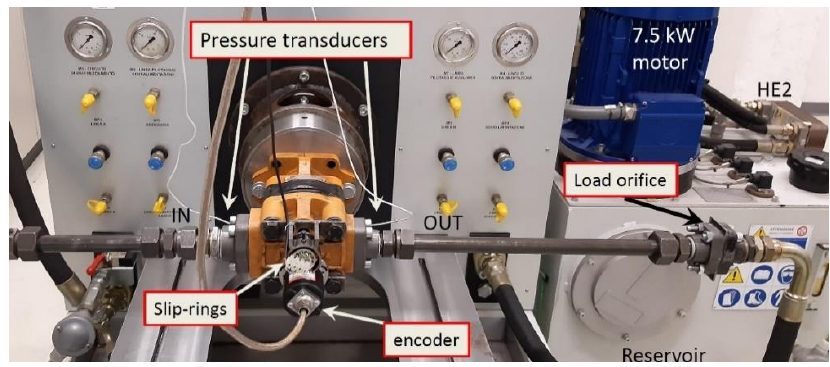
Figure 3. Frontal view of the test rig.